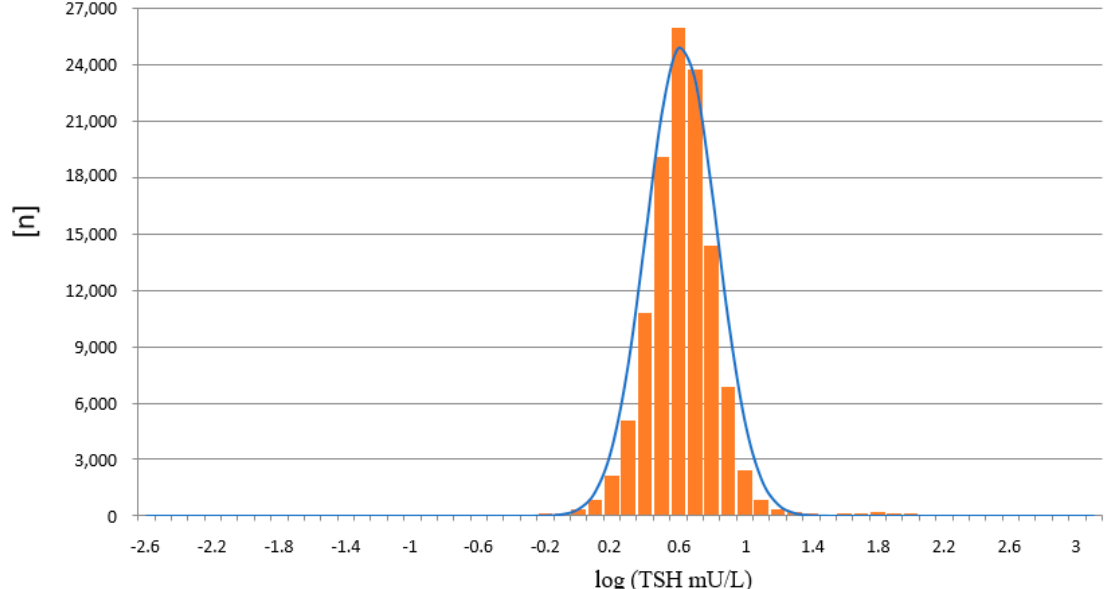
Figure 7. Distribution of TSH values measured on the PE/GSP platform, after logarithmic transformation ( n = 748,180).